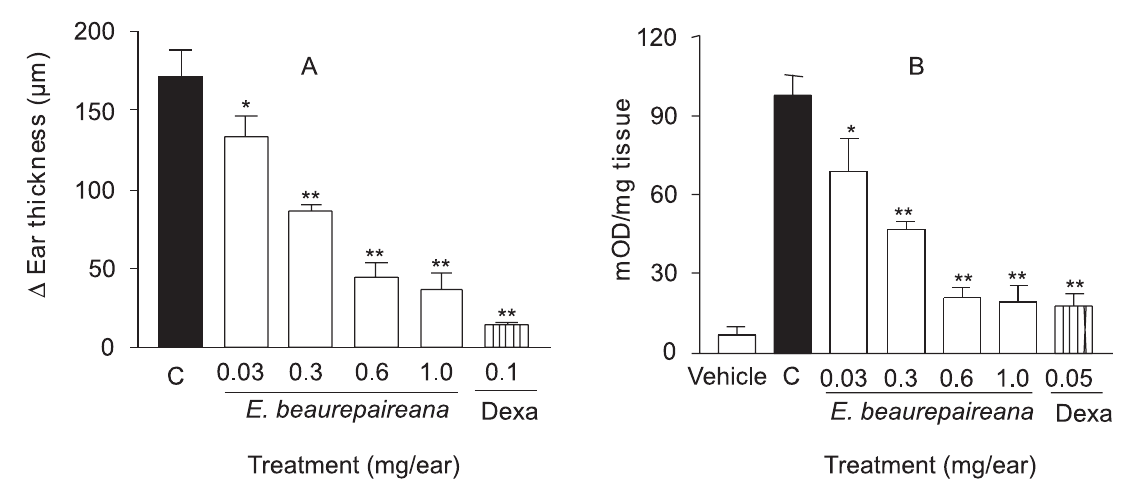
FIGURE 2 - Effect of Eugenia beaurepaireana and dexamethasone (Dexa) administered topically on (A) croton oil-induced ear edema and (B) myeloperoxidase activity in supernatants of homogenates from croton oil -treated ears. C = control; mOD = optical density (10 -3 ). Ear edema and myeloperoxidase activities were measured at 6 and 24 h after croton oil treatment, respectively. Each point represents the mean ± S.E.M. for 6 -8 animals. The asterisks denote the significance levels when compared with control groups. Significantly different from controls, *P<0.05 and